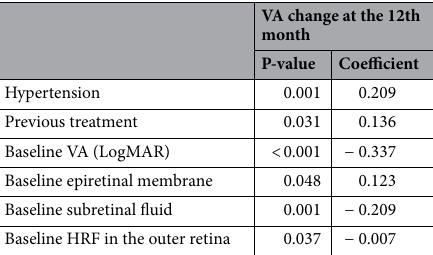
Table 2. Baseline factors associated with best-corrected visual acuity improvement at 1 year in patients with diabetic macular oedema under anti-vascular endothelial growth factor therapy. VA visual acuity, HRF hyperreflective foci.